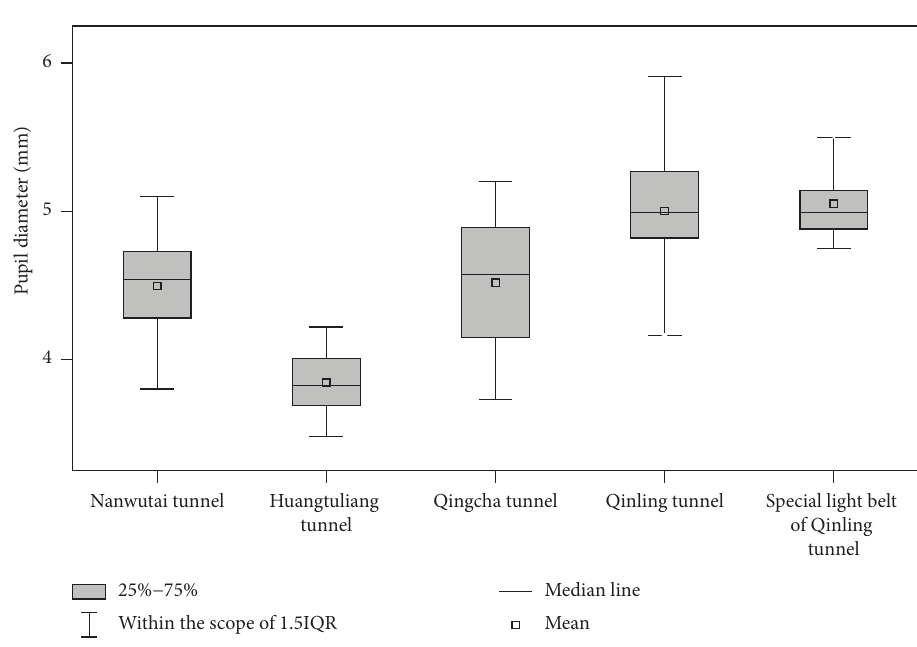
Figure 6: Box line graph of pupil diameters of driver in each